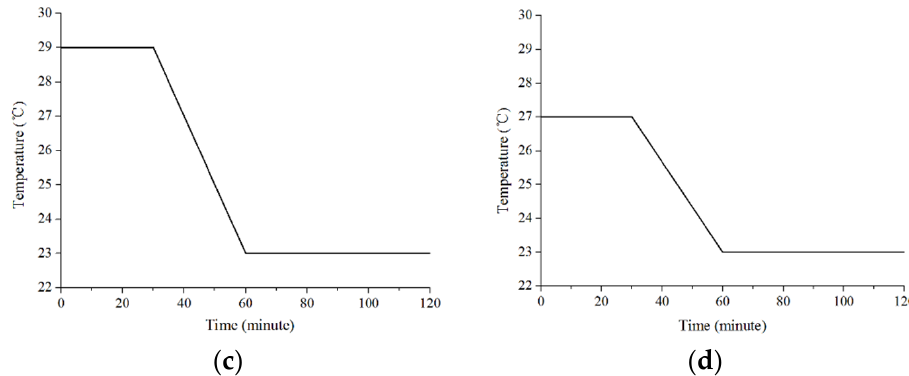
Figure 1. Timelines of the four experimental scenarios. ( a ) Scenario A: 29 → 27 °C. ( b ) Scenario B: 29 → 25 °C. ( c ) Scenario C: 29 → 23 °C. ( d ) Scenario D: 27 → 23 °C.